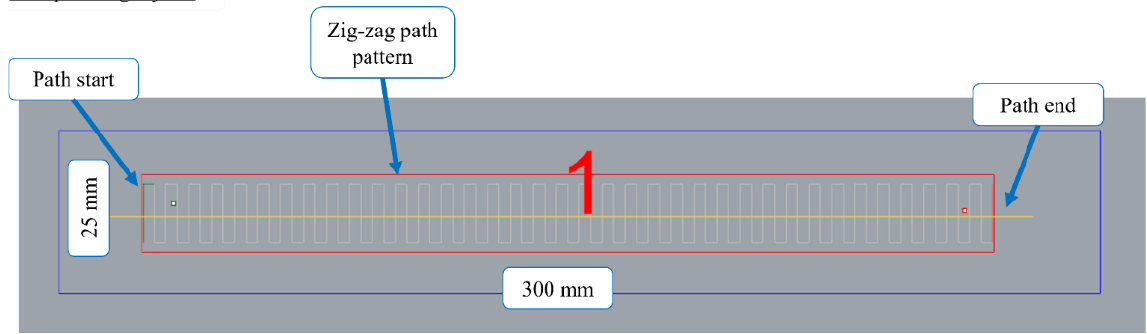
Figure 4. Deposition Path Planning for Layer 1 of an experimental WAAM wall. Table 1. Deposition Parameters .